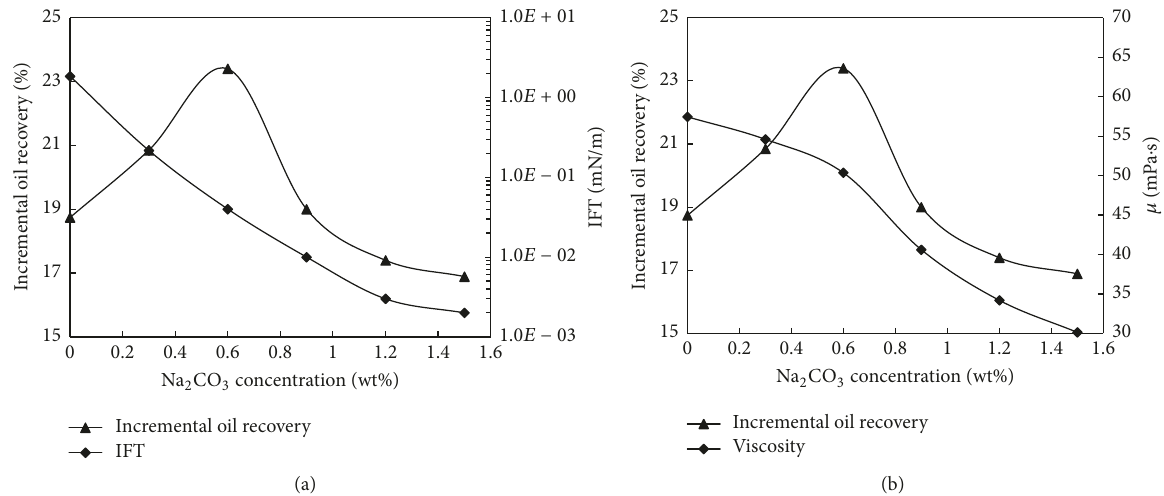
Figure 8: (a) Relationship between incremental oil recovery and IFT when Na 2 CO 3 concentration varies. (b) Relationship between incrementaloilrecoveryandviscositywhenNa 2 CO 3 concentrationvaries.Thesurfactantconcentrationis0.3 wt%andpolymerconcentration is 2000 mg/L.